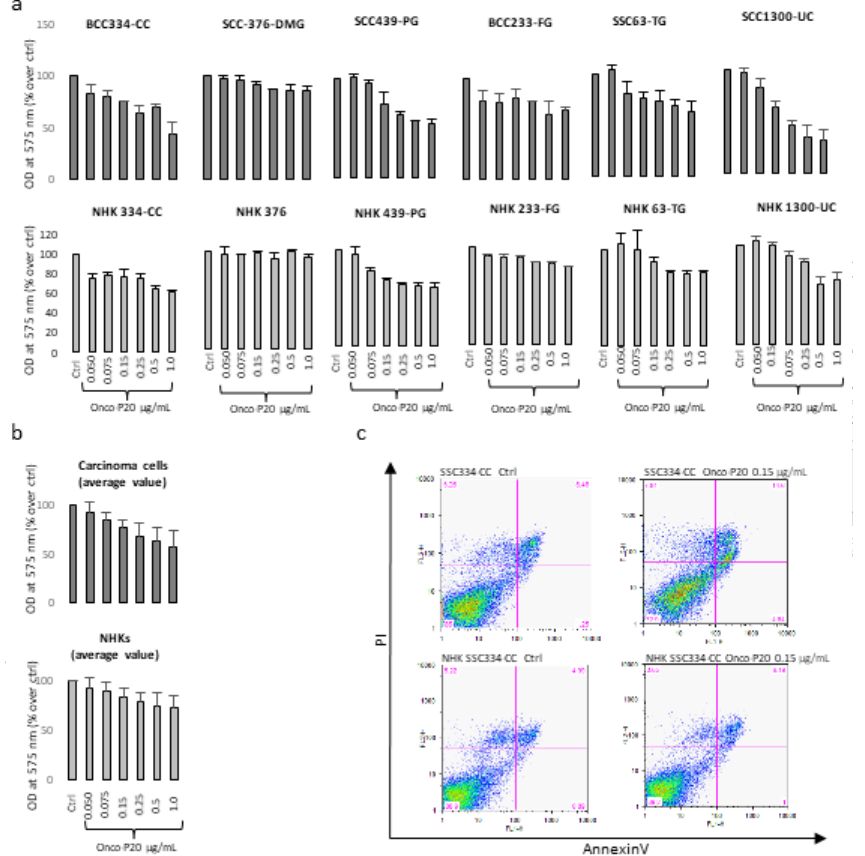
Figure 2. ( a ) MTT assay of several different NMSC cell lines and patient-matched NHKs after 72 h of treatment with Onco-P20 (range 0.05–1.0 µ g/mL). Data are reported as optical density (OD). ( b ) Data are also reported as mean value ± SD. Experiments were performed in duplicate. ( c ) AnnexinV/iodide propidium staining evidenced apoptotic cell death only in carcinoma cells. Dot plots show one representative experiment performed 24 h after Onco-P20